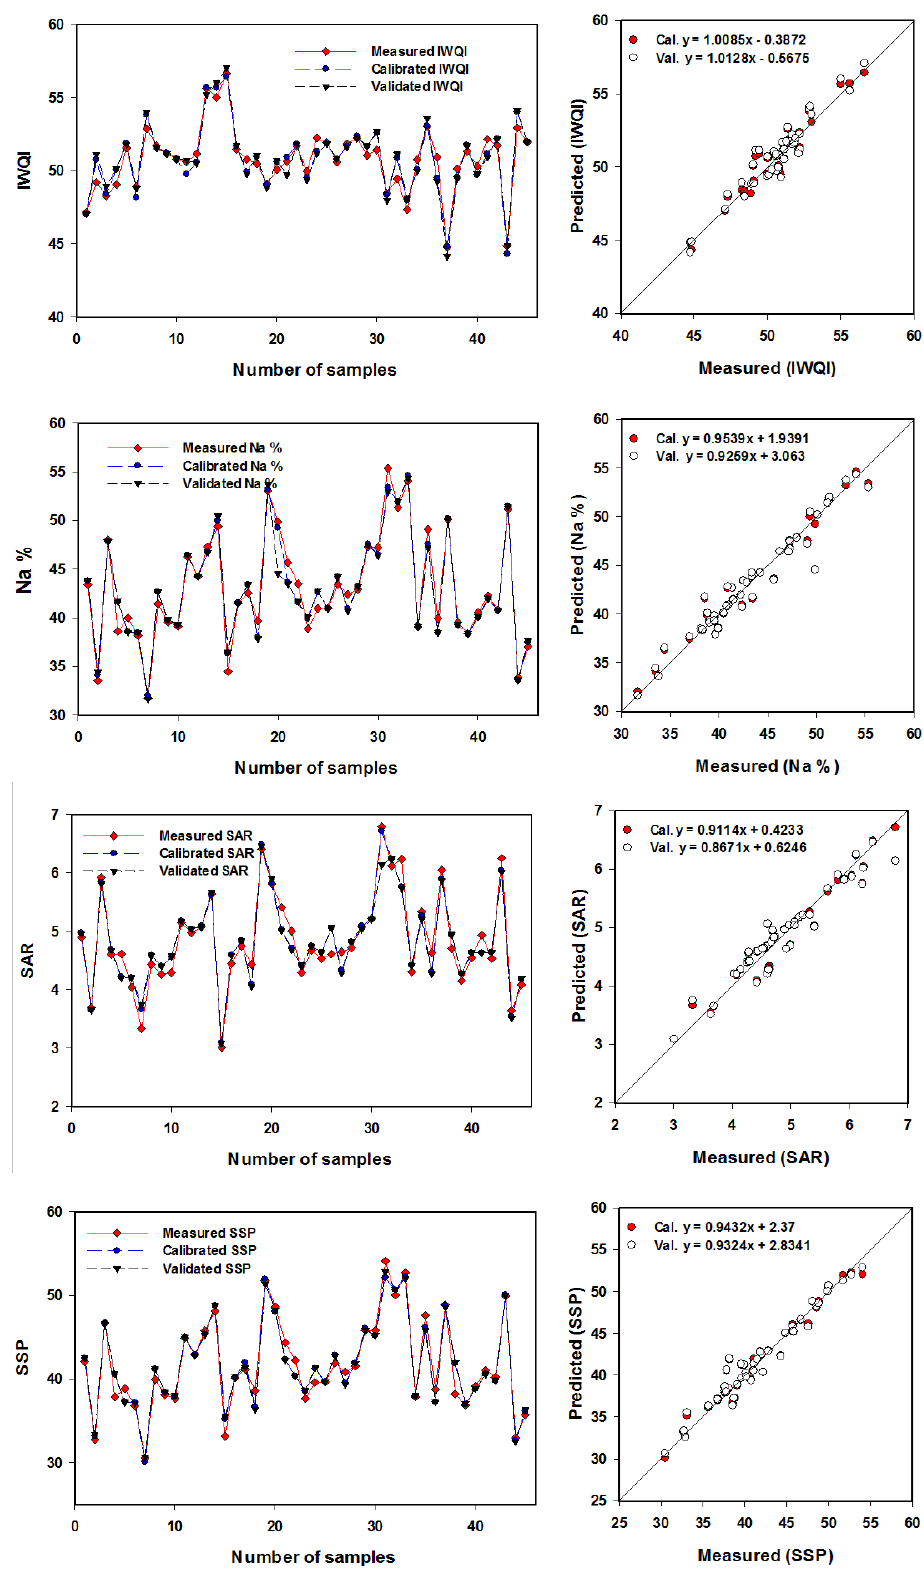
Figure 10. Relationships between the measuring, calibration, and validating datasets of the output (IWQI, Na%, SAR, and SSP) using the SVMR models. The results of the statistical analysis are displayed in Table 6.